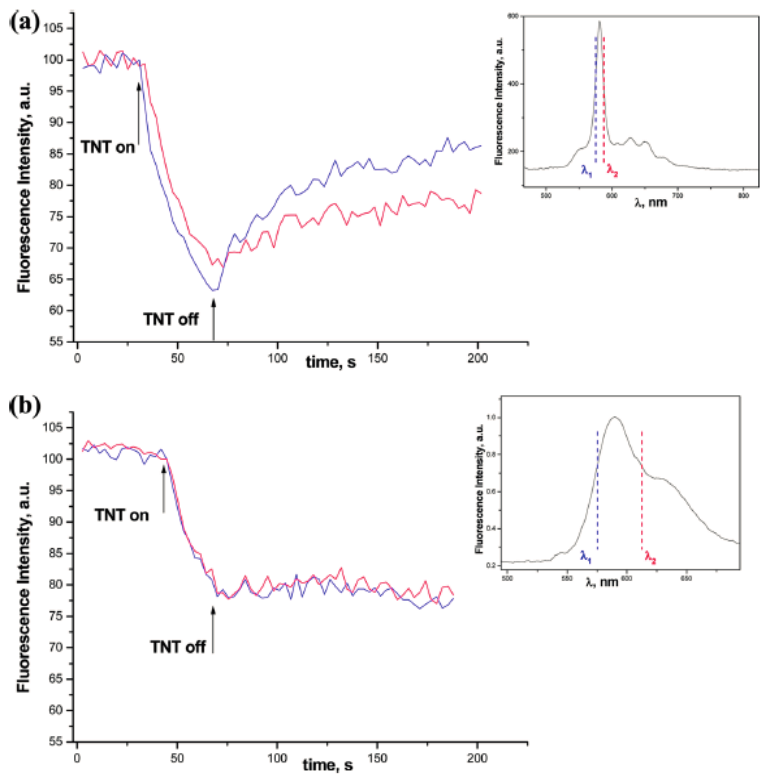
Figure 4. Time traces recorded at λ 1 and λ 2 wavelengths of the fluorescence intensity for ( a ) PSi MC infiltrated with MEH-PPV and ( b ) MEH-PPV film deposited on the flat Si substrate upon exposure to saturated TNT vapors (~7 ppb). Insets show λ 1 and λ 2 wavelengths on corresponding spectra with colors matching time traces. Reprinted with permission from Reference [21]. Copyright 2013 American Chemical